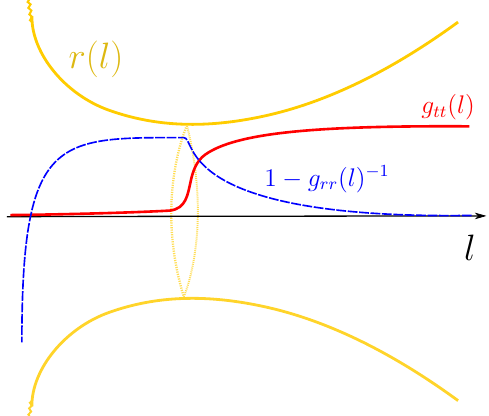
Figure 1. Pictorial representation of the semiclassical Schwarzschild geometry. The horizon is replaced by the neck of an asymmetric wormhole, which is a minimal surface for the areal radius r ( l ) , l being the proper radial coordinate. Space to the right of this surface connects with the asymptotically flat region, while to the left, it ends in a null singularity at finite proper distance. The red curve represents the redshift function of the geometry, which is positive everywhere but at the singularity. The blue dashed line is the quotient between the Misner–Sharp mass and r , which shows how mass is distributed throughout the